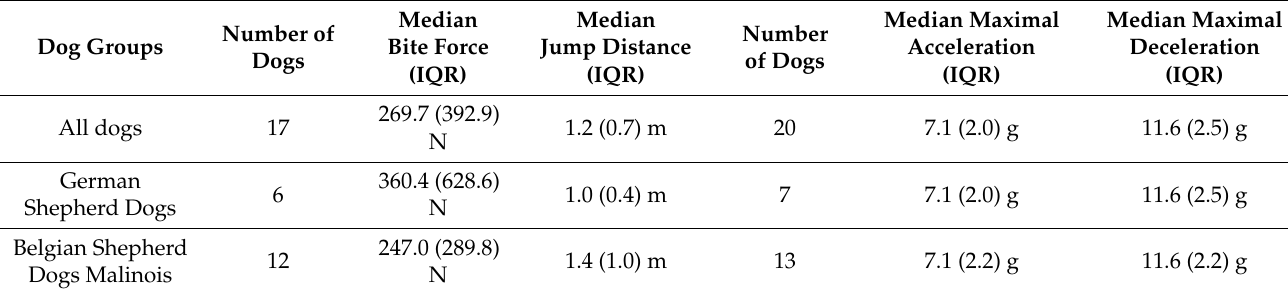
Table 2. Descriptive information on bite forces, jump distance and maximal acceleration and deceleration forces of the dogs in this